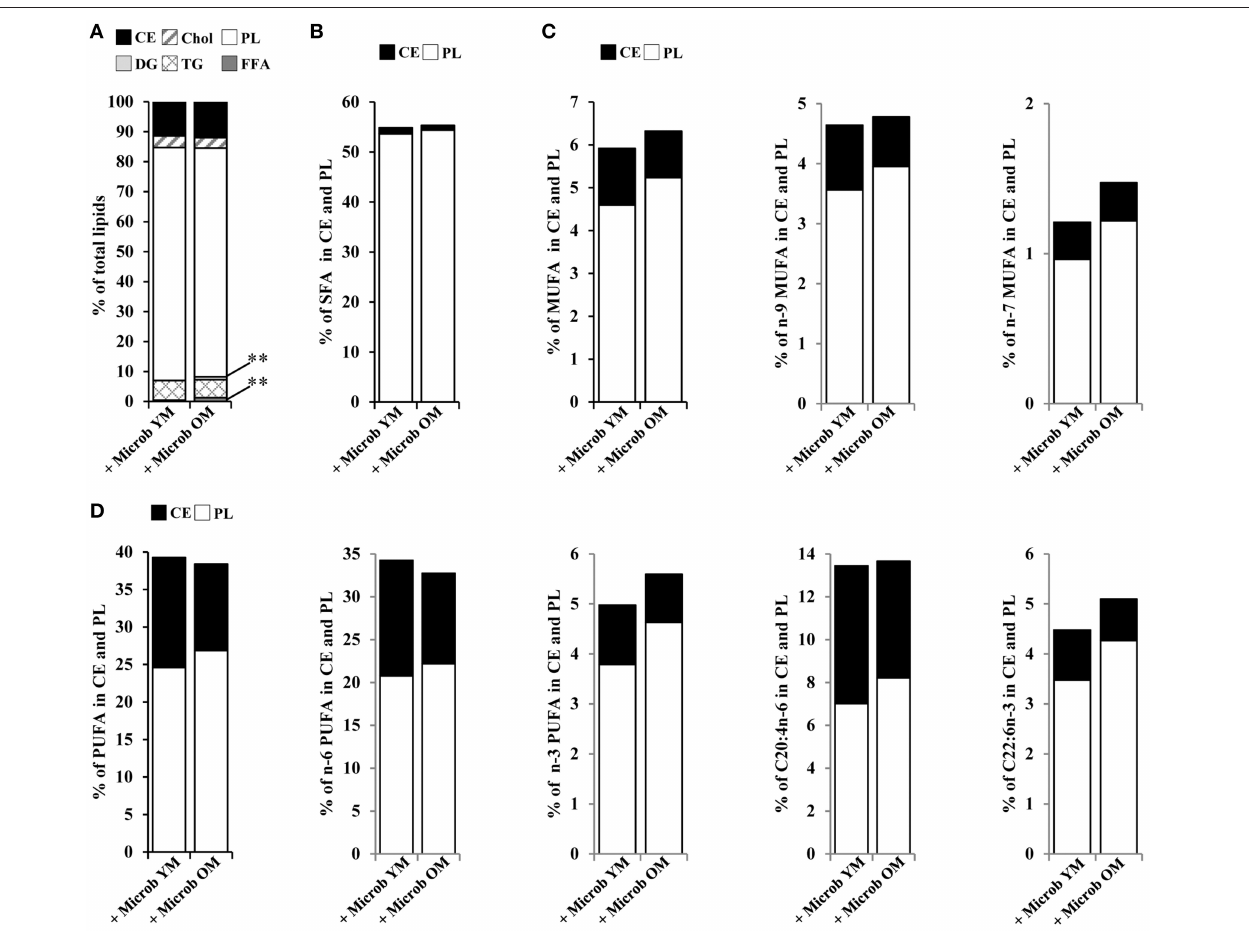
FIGURE 5 | Plasma lipid and fatty acid profile in mice inoculated with different age-related microbiota. Lipids were extracted from the plasma of mice inoculated with fecal microbiota of young mice ( + Microb YM) or old mice ( + Microb OM). (A) Relative abundance of lipid classes. Results are expressed as the percentages of cholesteryl esters (CE), cholesterol (Chol), phospholipids (PL), diglycerides (DG), triglycerides (TG), and free fatty acids (FFA) relative to total lipids, defined as 100%. (B–D) Total lipid extract was separated on silica gel. CE and PL were extracted and their fatty acid profiles were determined by GC-FID. To express the results, we took into account the relative proportions of CE and PL measured in the total lipid extracts. Results are expressed as percentages of (B) total saturated fatty acids (SFA), (C) monounsaturated fatty acids (MUFA), and (D) polyunsaturated fatty acids (PUFA) on CE and PL in total lipid extracts, defined as 100%. All data are presented as mean. n = 7 for the group of mice inoculated with the microbiota of young mice and n = 7 for the group of mice inoculated with the microbiota of old mice. ** p <